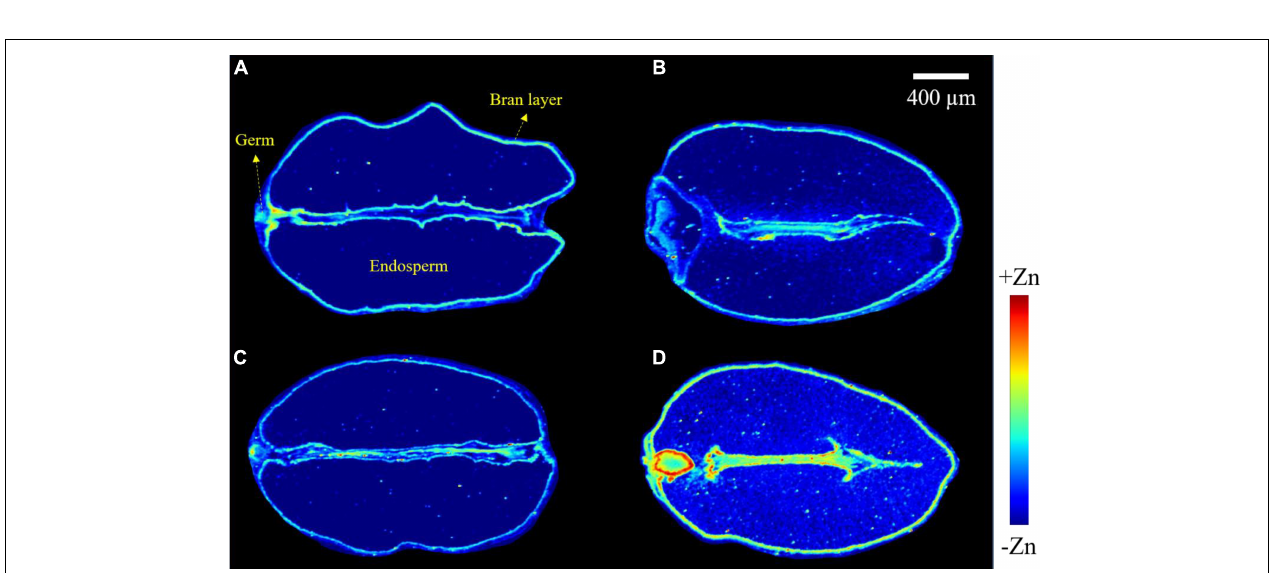
FIGURE 4 | Micro X-ray fluorescence ( µ -XRF) elemental maps for Zn of grains collected from wheat plants subject to different foliar fertilizers: − Zn-CK (A) , +Zn-CK (B) , − Zn+Ino (C) , and +Zn+Ino (D) . Pixel brightness for µ -XRF maps (A–D) is displayed in RGB, with the brightest spots corresponding to the highest elemental fluorescence. Scale bar: 400 µ m. n = 4, representative images shown.